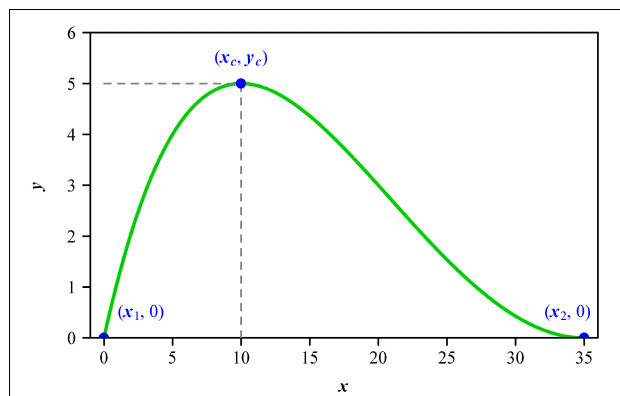
FIGURE 1 | The curve generated by the modified Lobry-Rosso-Flandrois (MLRF) equation, which represents a side of a lamina. Here, x 1 and x 2 represent the lamina base and lamina apex, respectively; x c represents the point on the lamina length axis associated with the lamina maximum width 2 y c ; δ controls the curvature of this curve. In this study, the location of lamina base (i.e., x 1 ) is fixed to be 0. This means that the MLRF equation only has four parameters: y c , x c , x 2 , and δ